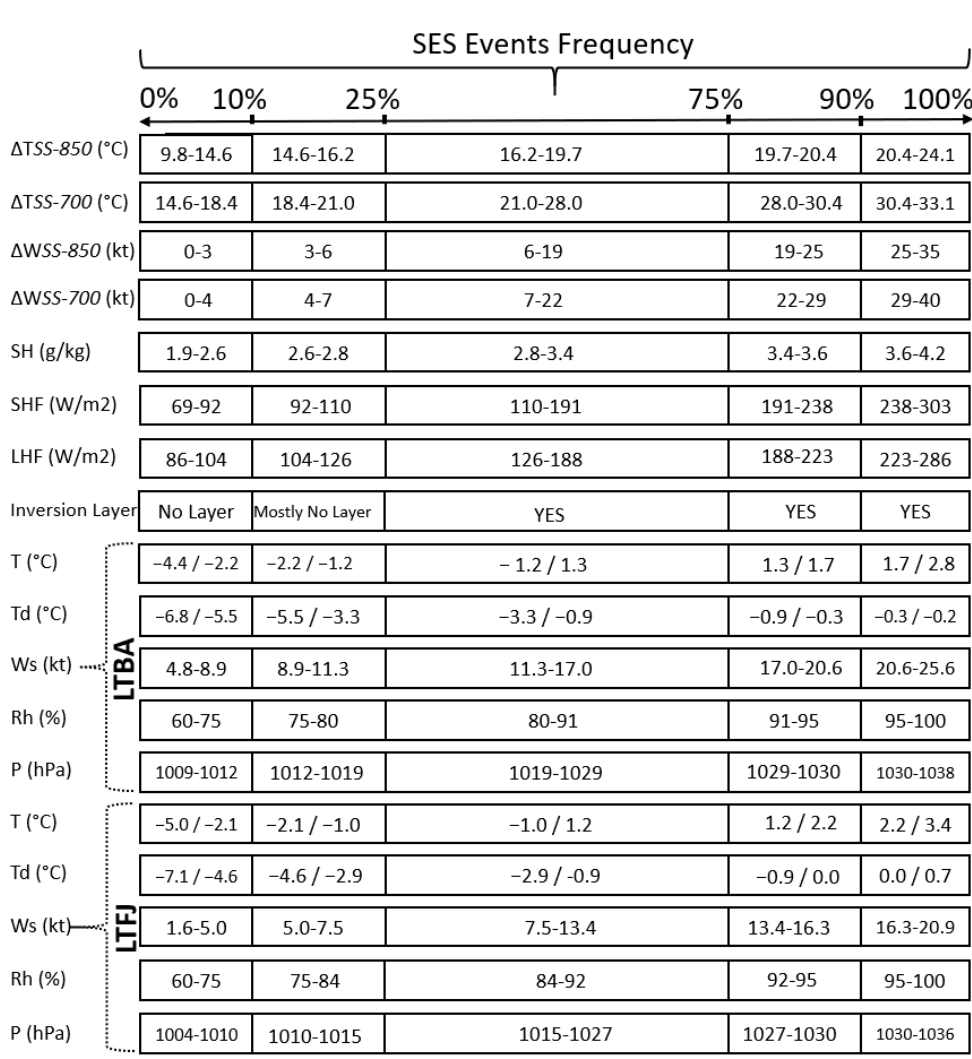
- T air temperature; Td dew point; Ws wind speed; Wd wind direction; RH relative humidity; P pres- sure; SS sea surface; SHF sensible heat flux; LHF latent heat flux; Spe. Hum. Specific humidity; VRB variable. 3.6. An Algorithm for the Prediction of SES Events at LTBA and LTFJ In this study, SES and non-SES events were analysed at the meso-scale. In this con-